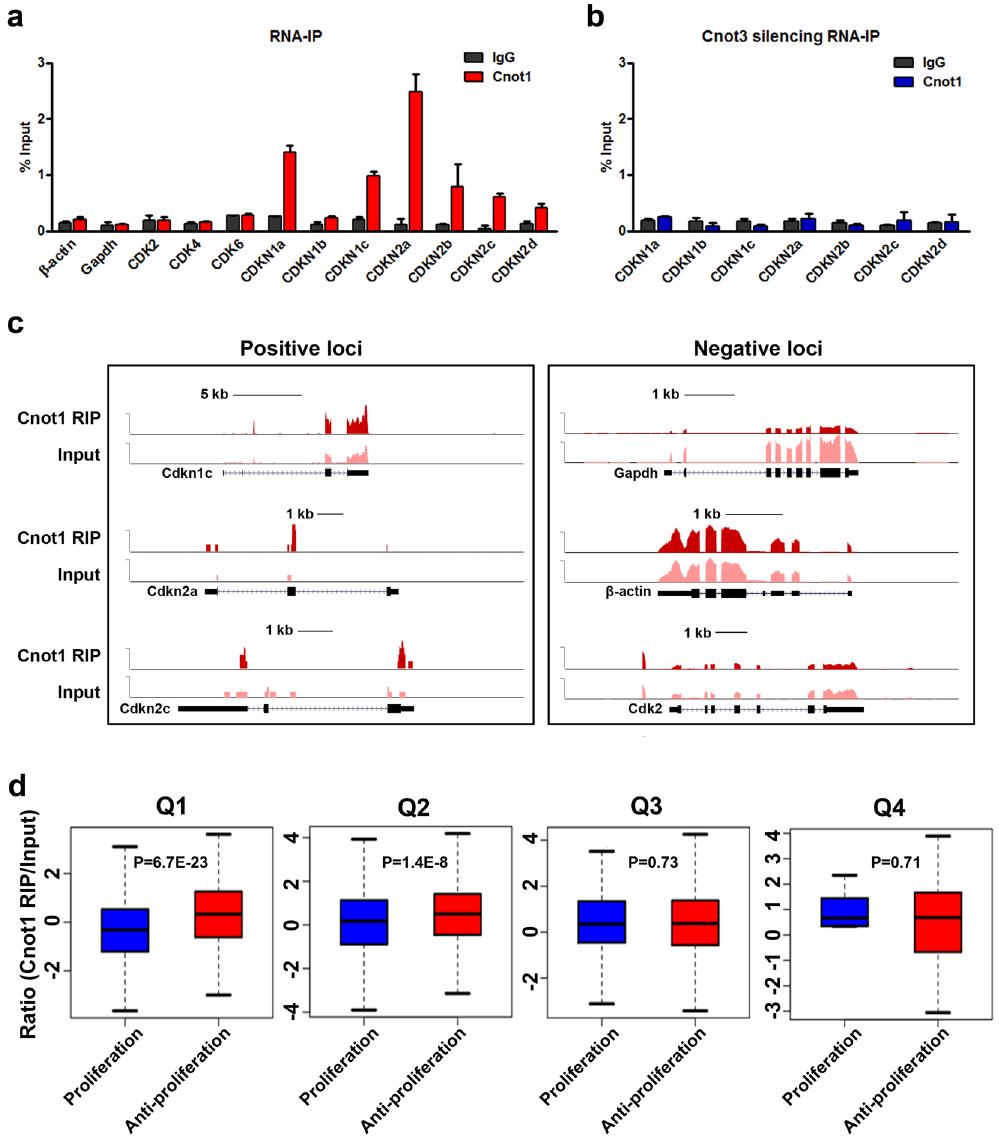
Figure 4. Cnot1 preferentially interacts with anti-proliferative gene transcripts in a Cnot3-dependent manner. (a) Cnot1 interaction with mRNAs. RIP was performed in hESC-derived cardiomyocytes with either IgG or Cnot1 antibody. Relative abundance of the immunoprecipitated mRNAs was determined by RT-qPCR, normalized to Input, and plotted as mean ± SEM from three independent experiments. ( b ) Effects of Cnot3 silencing on Cnot1 RIP. hESC-derived cardiomyocytes were transduced with shCnot3, and RIP was conducted 48 h after transduction. Values were plotted as mean ± SEM from three independent experiments. ( c ) Cnot1 RIP sequencing. Cnot1 RIP was performed in hESC-derived cardiomyocytes, and the total and Cnot1-interacting RNAs were subjected to high-throughput sequencing. Representative images form the genome browser were shown for the indicated genes. For each gene, upper track: Cnot1 RIP; lower track: Input. ( d ) Statistical analysis of Cnot1 RIP-sequencing. Genes detected in the sequencing were ranked by their expression level in hESC- derived cardiomyocytes and divided into four equal groups (Q1–Q4). Cnot1 binding was determined by the ratio of the reads per kilo base per million (RPKM) in Cnot1 RIP/Input and compared between Proliferative and Anti-proliferative genes in each quarter. Proliferative genes were defined as those downregulated in long- term cultured hESC-CMs, while Anti-proliferative genes were defined as those upregulated (See Experimental Procedures for details). P values were calculated by the Wilcoxon rank-sum